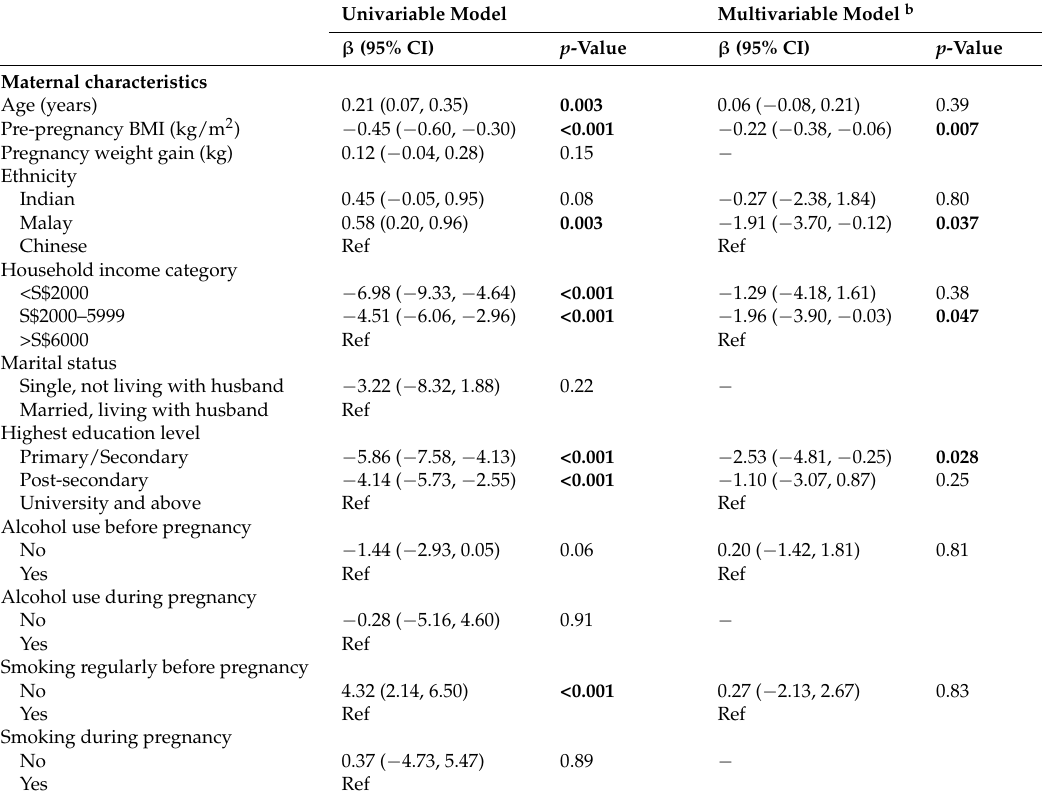
Table 4. Associations between sociodemographic and lifestyle factors and toddler DQI in the GUSTO cohort study ( n = 561) a